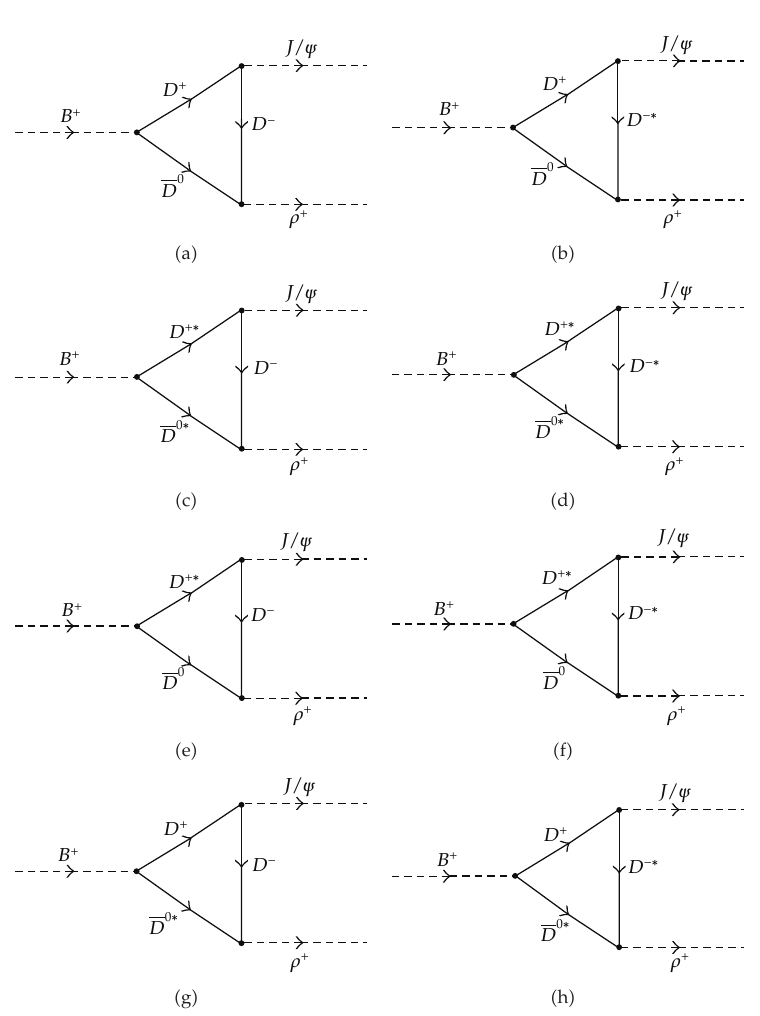
Figure 4: HLL diagrams for long-distance t -channel contribution to B (cid:2) → J/ψρ (cid:2)